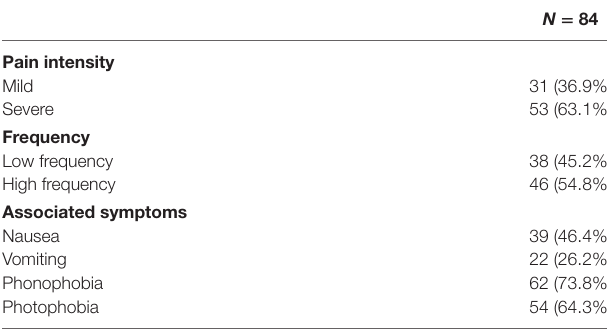
Table 3 | Headache characteristics of our